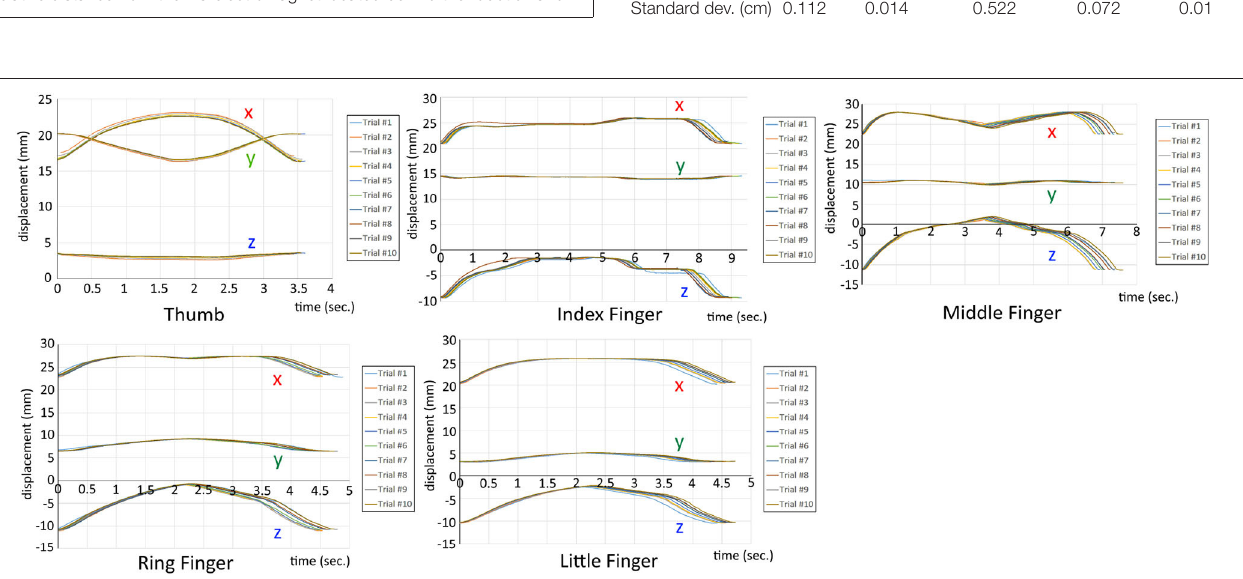
Frontiers in Bioengineering and Biotechnology |